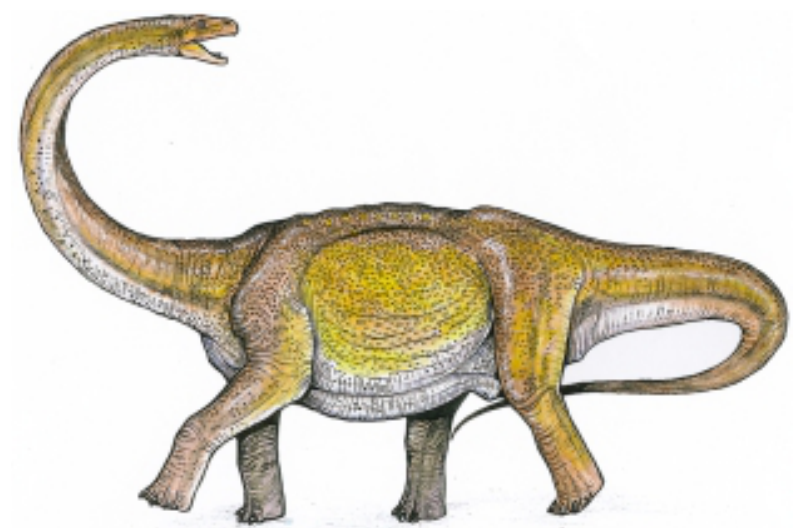
Fig. 11–Reconstructionof Gondwanatitanfaustoi , atitanosauridsauropod. Scale bar: 1 m.